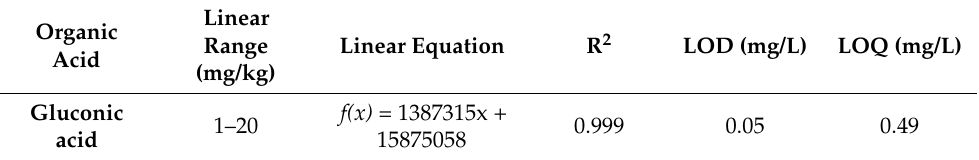
Table 1. Linear ranges, linear equation, the coefficient of determination (R2), and limit of detection (LOD) and quantification (LOQ) for gluconic acid.